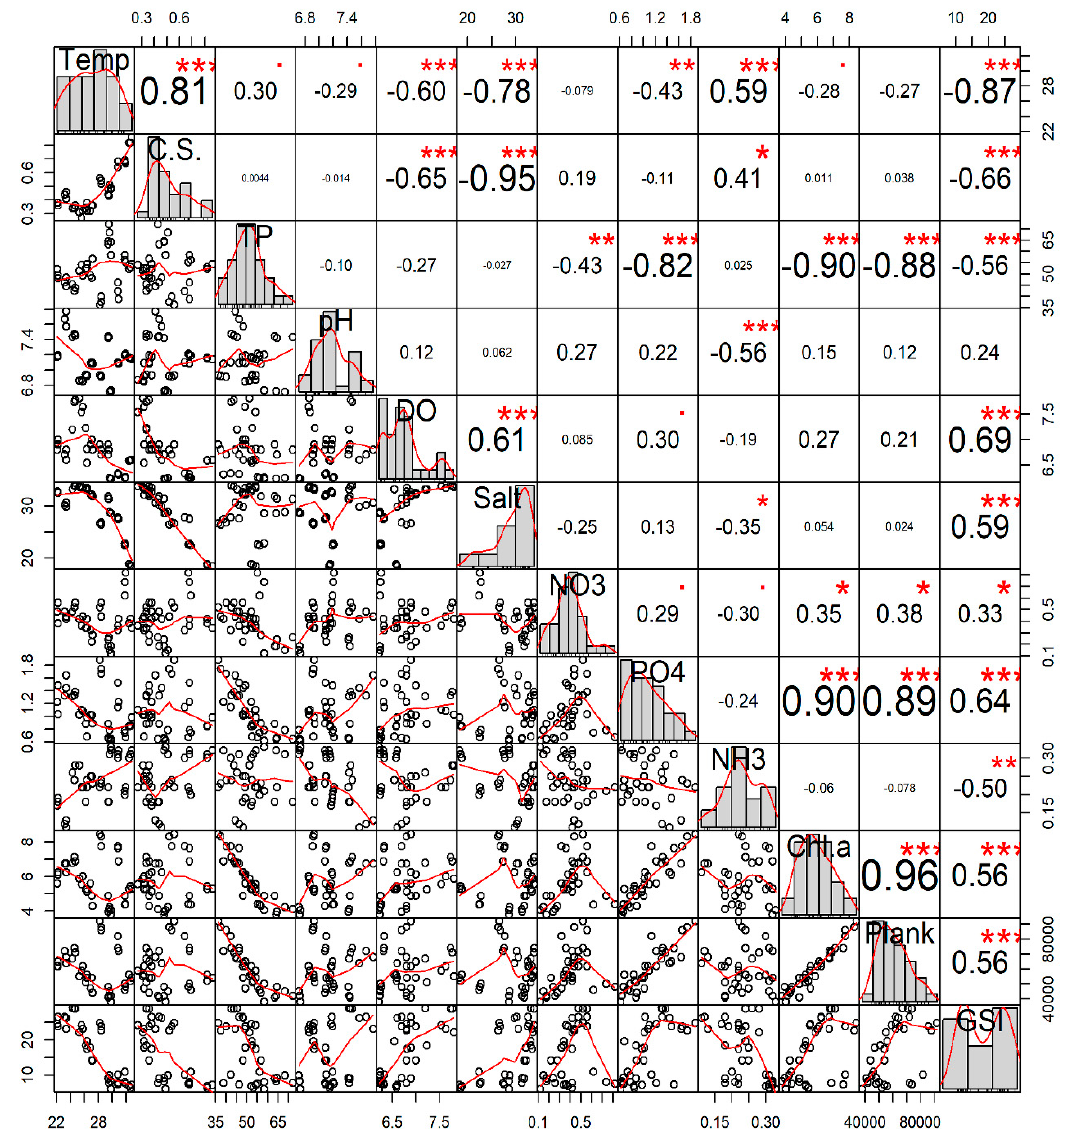
Figure 5. Interrelations among the different water quality parameters and the gonadosomatic index (GSI) of green mussel Perna viridis collected from the coastal waters of Bangladesh. The analysis is based on the three replicated measurements of water quality parameters for each month (n = 36). Here, the variables’ full names are: Temp, water temperature (°C); C.S., water current speed (m/s); TP, water transparency (cm); pH, water pH; DO, dissolved oxygen (ppm); Salt, salinity (ppt), NO3, nitrate-nitrogen (ppm); PO4, phosphate-phosphorus (ppm); NH3, ammonia-nitrogen (ppm); Chl.a, chlorophyll a (µg/L); Plank, water total plankton (cells/L); and GSI, gonadosomatic index (%). Values given around the all axis are the range of the individual parameters’ measured values. Correlation coefficients are indicated with numeric values, while significance levels are denoted by asterisks (* < 0.05, ** < 0.01, *** < 0.001).